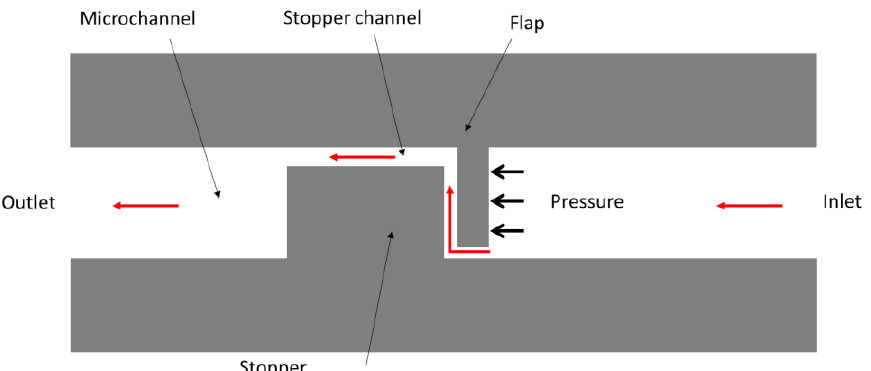
Figure 13. Schematic top view of a planar PDMS microfluidic flow regulator. The flow direction is indicated by red arrows. The flow restriction between the flap narrows with the applied pressure to maintain the flow rate constant.